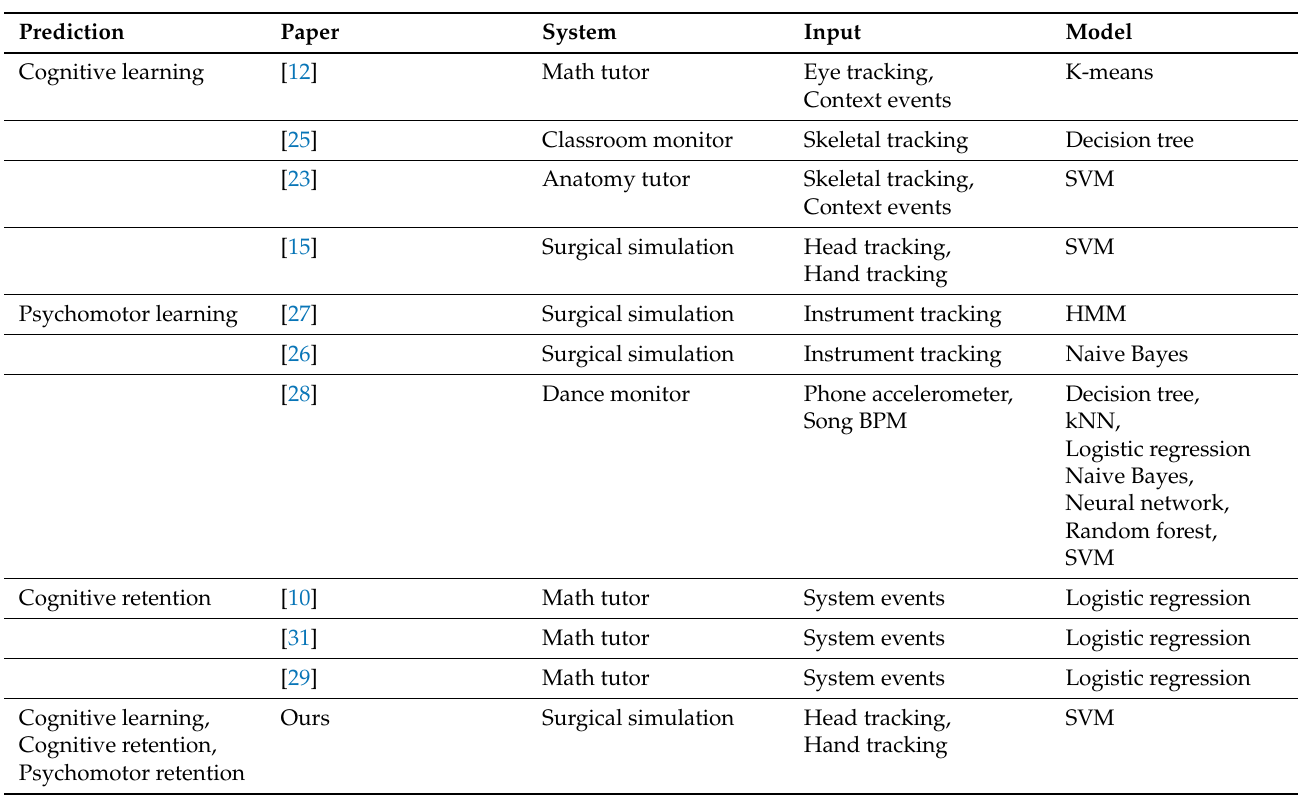
Table 1. An overview of related work that have predicted learning and retention